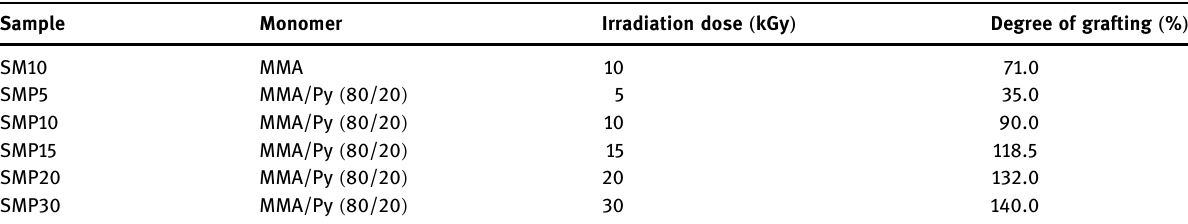
Table 1: E ff ect of irradiation dose on DG% of the grafted LDPE fi lms Sample